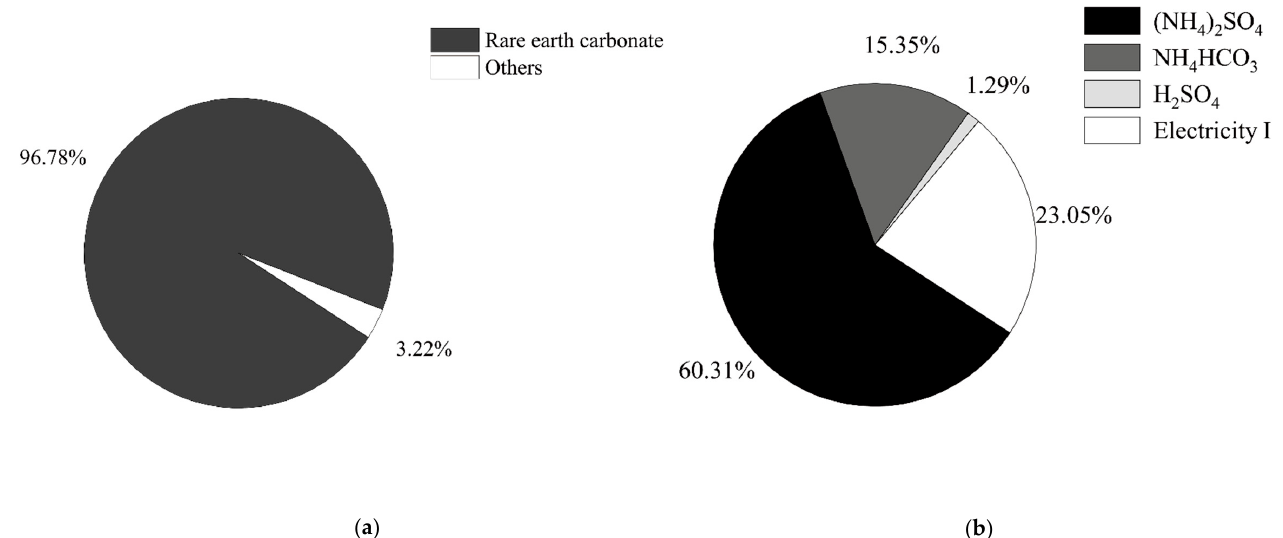
Figure 2. Carbon footprint analysis of ionic rare earth development. ( a ) Carbon footprint contribu- tion of in situ leaching. ( b ) Oxidative burning carbon footprint